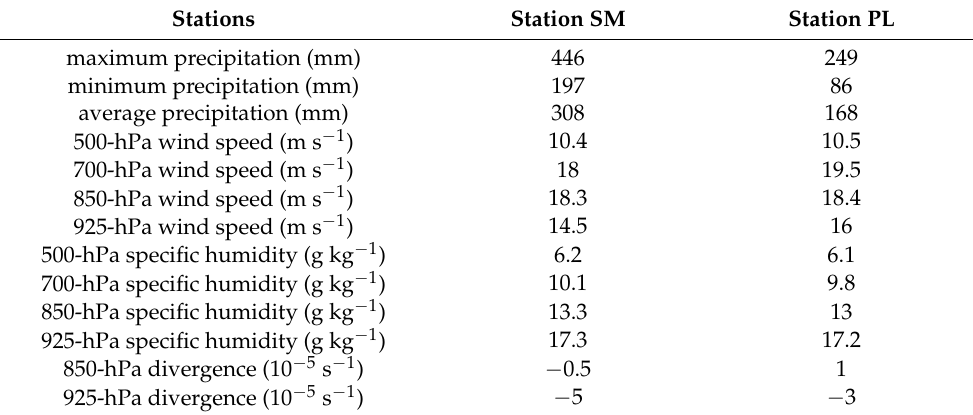
Table 1. Precipitation and physical variables comparison between station SM and station PL during Stage1. Stations Station SM Station PL maximum precipitation (mm)